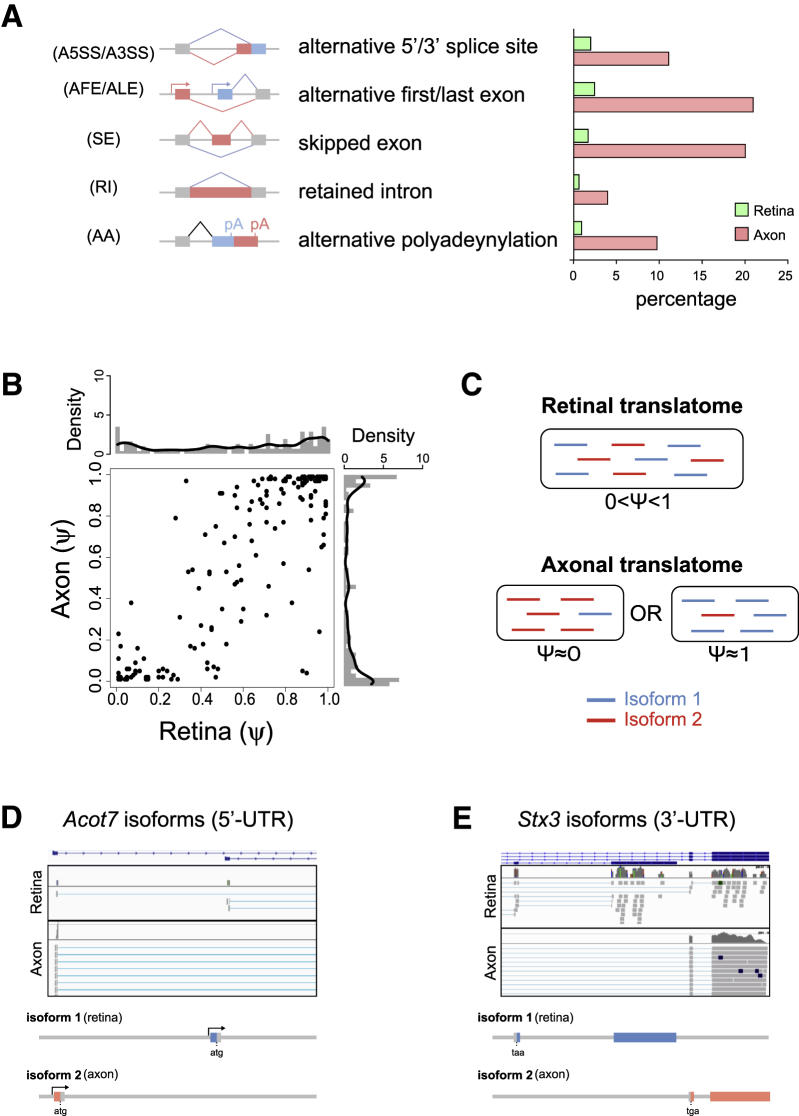
Alternative Splicing Generates High Isoform Diversity in Axons(A) Percentage of genes with alternative events from all axonally translated genes. Alternative events are classified into five different classes depicted in the left panel.(B) Scatter and density plots for the distribution of percentage spliced in (Ψ) values between the retina (x axis) and the axon (y axis).(C) Model for biased distribution of Ψ values in the axon. The comparison of two isoforms suggests that one of two isoforms is predominant in the axon.(D and E) The sequence reads on Acot7 and Stx3 loci visualized with integrative genomics viewer (IGV). The histograms show the depth of the reads displayed at each locus. The retinal isoforms are detected only in the retinal translatome, whereas the axonal isoforms are detected both in the axonal and retinal translatomes.See also Figure S6.